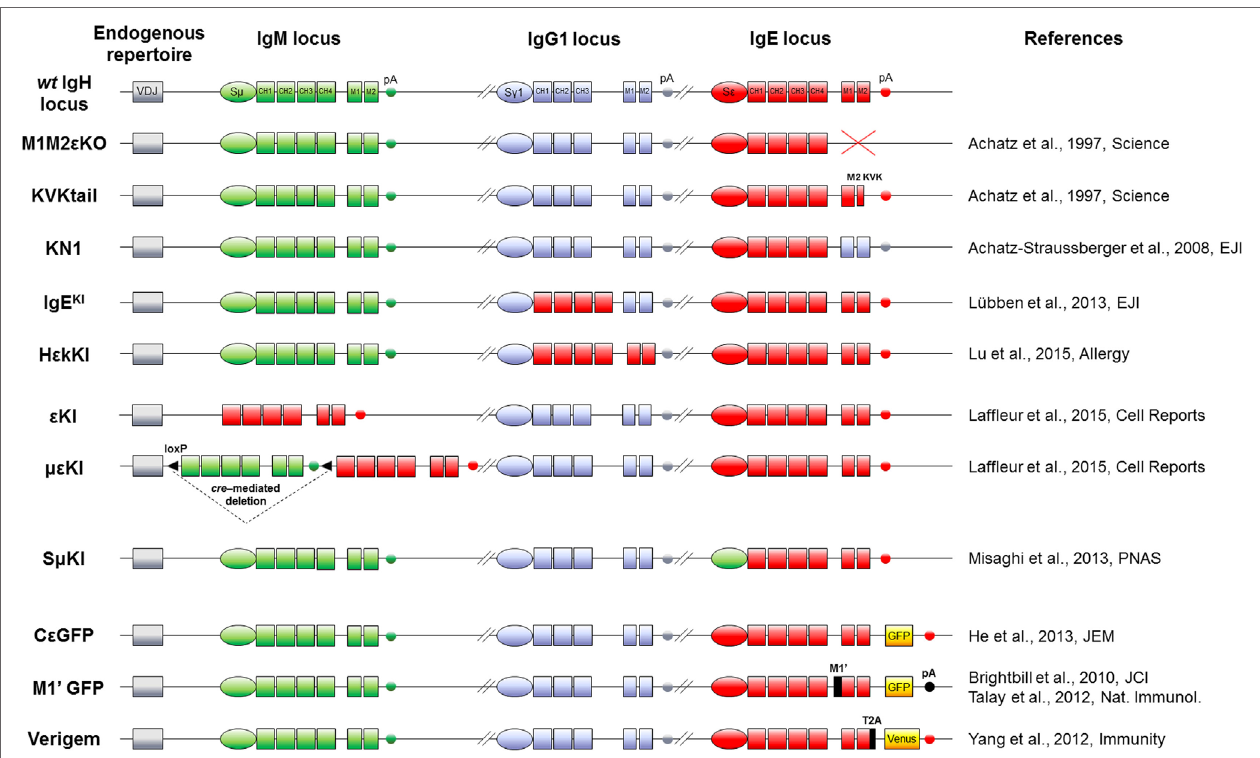
FigURe 2 | IgH mouse models to study IgE responses in vivo . Top: mouse WT IgH locus is represented after VDJ recombination (not to scale). IgM (green), IgG 1 (blue), and IgE (red) loci including their switch regions (S), constant exons (CH), membrane genes (M), and membrane polyadenylation sites (pA) are shown. Middle: knock-out and knock-in alleles are represented, using the color code (IgM elements in green, IgG 1 in blue and IgE in red) for modifications of switch regions, exons and polyadenylation sites. Bottom: the three last models feature insertion of fluorescent reporter genes (yellow boxes) and exogenous sequences (black). Name and references of each mouse model are specified on